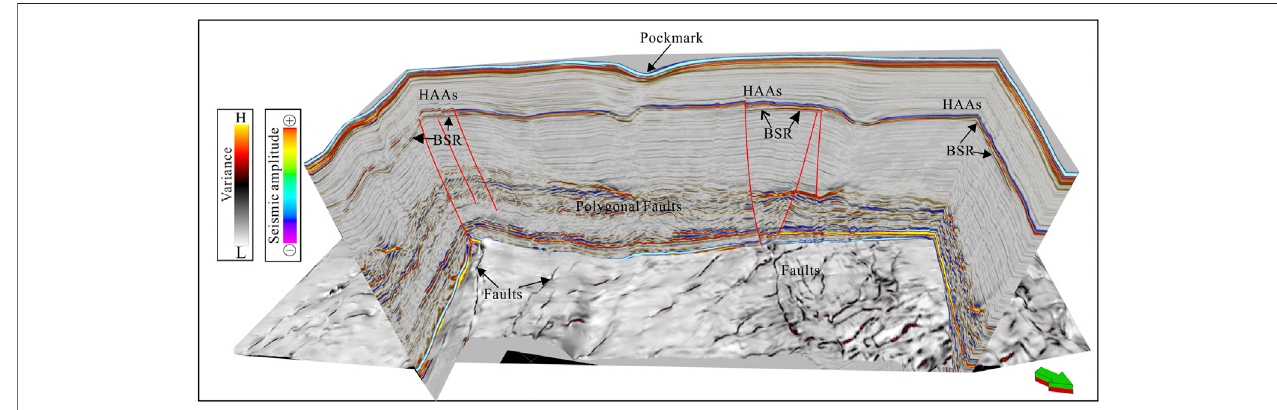
FIGURE 9 | 3D perspective view of the coherence slice map of the T5 horizon shows the normal fault formed by tectonics combined with the cross-sections. The BSRs and high amplitude anomalies (HAAs) have been identi fi ed.